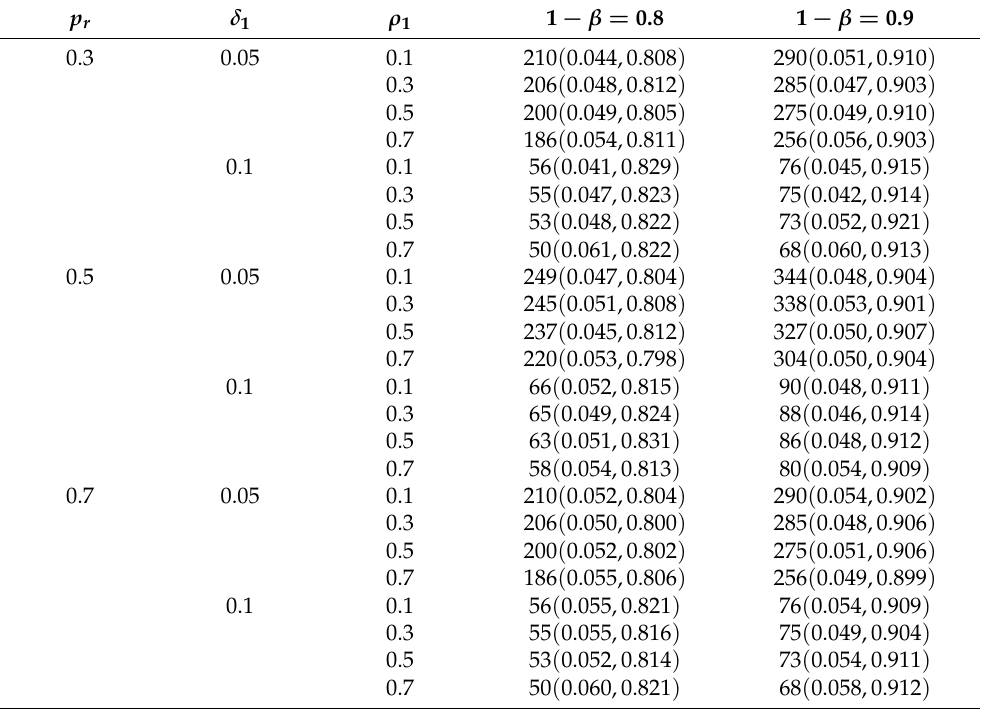
Table 1. Sample size (empirical type I error rate, empirical power), n ( ˆ α ,1 − ˆ β ) , under various design settings of ( p r , δ 1 , ρ 1 ,1 − β ) for the first type of study